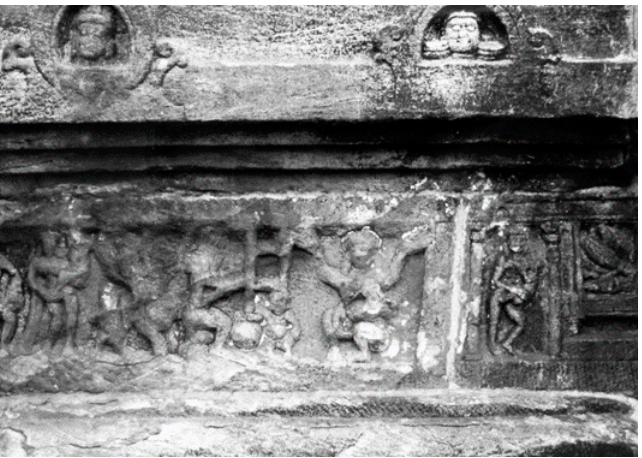
Figure 7. Exploits of the Young K ṛṣṇ a (left to right): Arrival of K ṛṣṇ a at the Cowherd Village,